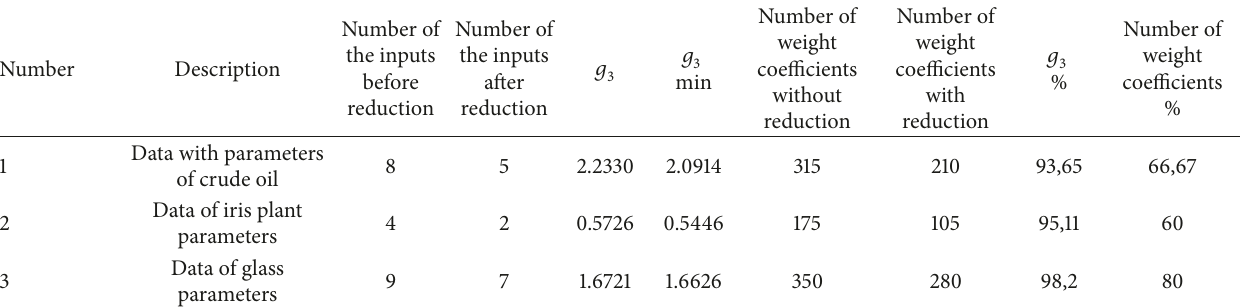
Table 13: Results from the